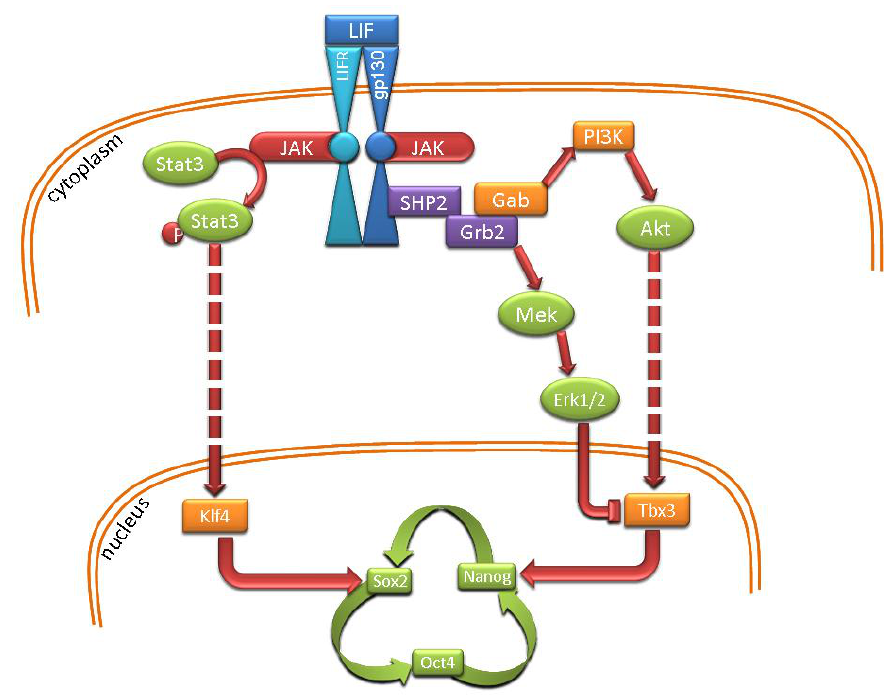
Figure 2. Diagrammatic representation of the pathways associated with leukemia inhibitory factor (LIF)-dependent pluripotency in mouse ES